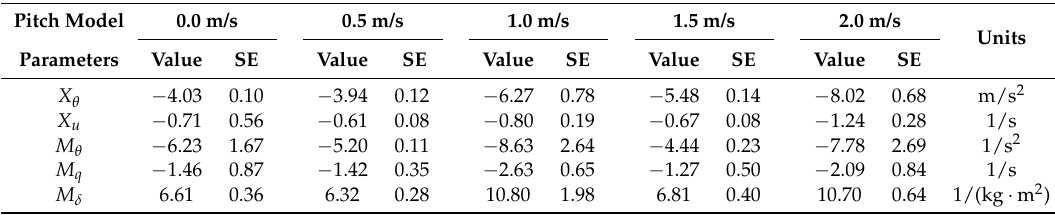
Table 6. Nominal pitch model parameter estimates.